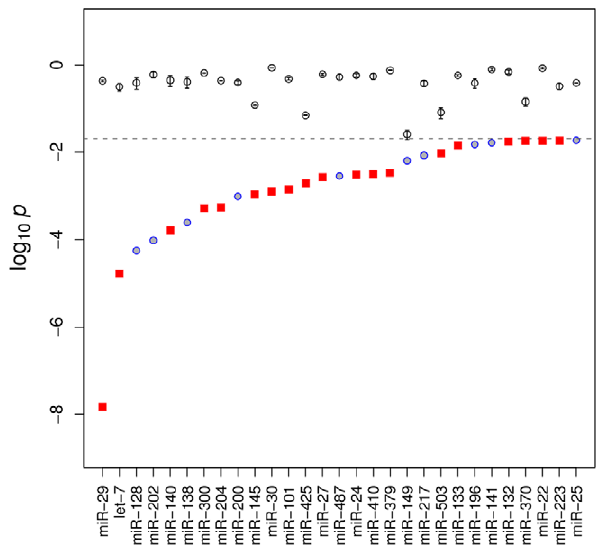
Figure 2. miRNA Signature Analysis of mRNA Gene Expression Data. miRNAs with significantly lower target-gene expression in the aortic samples from six-week old mice as determined by the Wilcoxon rank sum test [23]. The logarithm of the probabilities is shown as red squares (for miRNAs that themselves were found to be differentially expressed by microarray hybridization) or as blue circles (for miRNAs that were not differentially expressed). For instance, a value of log 10 p ~{ 5 for a given miRNA would correspond to a probability of 10 { 5 of observing the distribution of the corresponding miRNA seed sequences in the mRNA expression profile by chance. Additionally, the mean probability ( + standard error) derived from ten random sets is plotted for each miRNA as an additional circle with error bars.